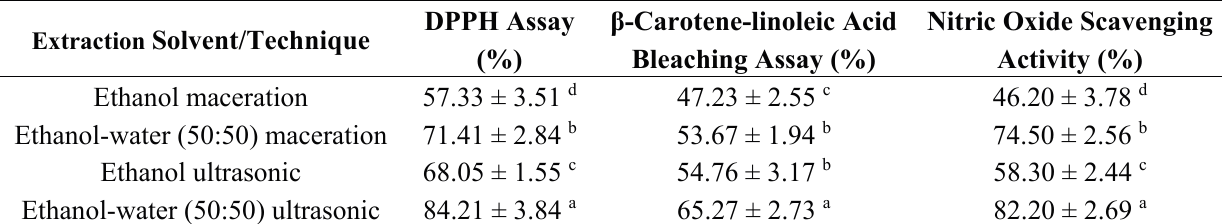
Table 2. Effects of extracting solvent/technique on the antioxidant activity of Hashemi rice bran extracts (100 µg/mL), using three different methods.